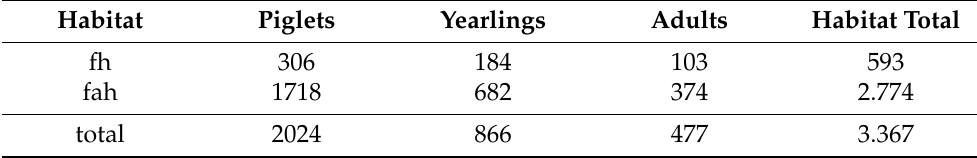
Table 1. Distribution of wild boar females according to age and habitat.